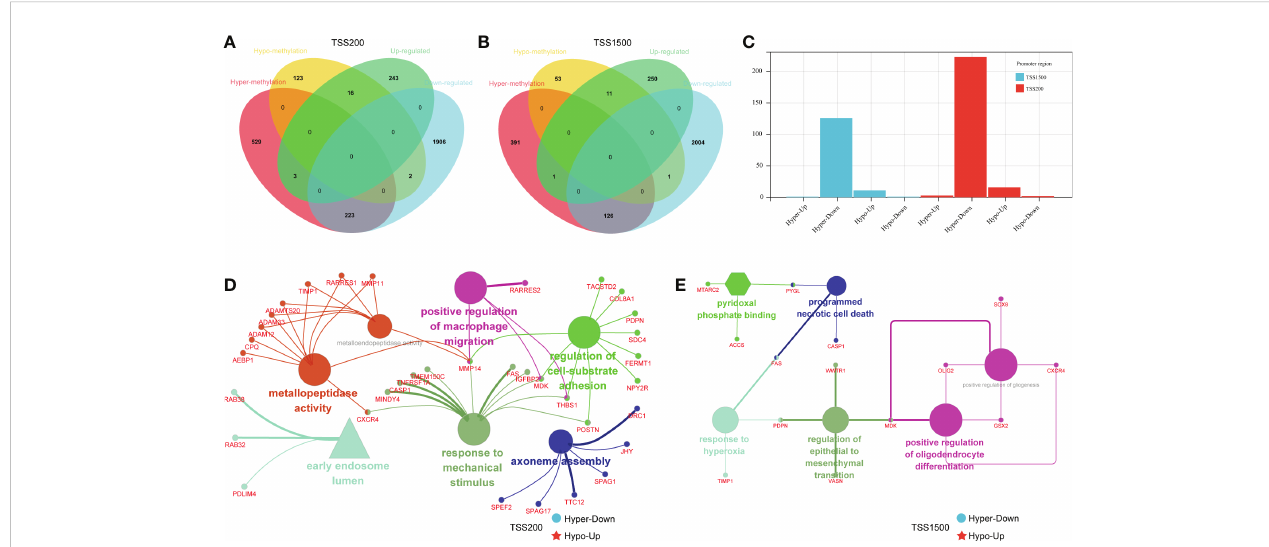
FIGURE 3 Grouping and functional analysis of DMEGs. (A, B) Venn diagram showed four different groups ( HypoDown, HyperUp, and HyperDown ) of DMEGs in the TSS200 region (A) and TSS1500 region (B) . (C) The bar chart shows the different groups of DMEGs in the two regions. (D, E) ClueGO Cytoscape network of statistically DMEGs in two regions.